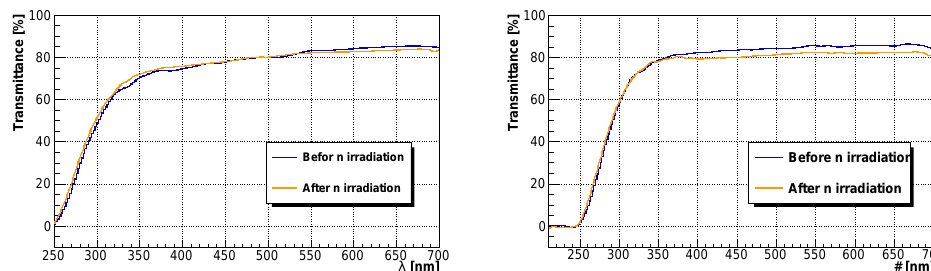
Figure 6. Transmission spectra obtained after the irradiation at FNG with 14 MeV neutrons for a total fluence of 10 13 n/cm 2 (orange line) compared with the results after the 16 hours optical bleaching (blue line) for the naked crystal ( left ) and for the crystal with Mylar wrapping ( right ).